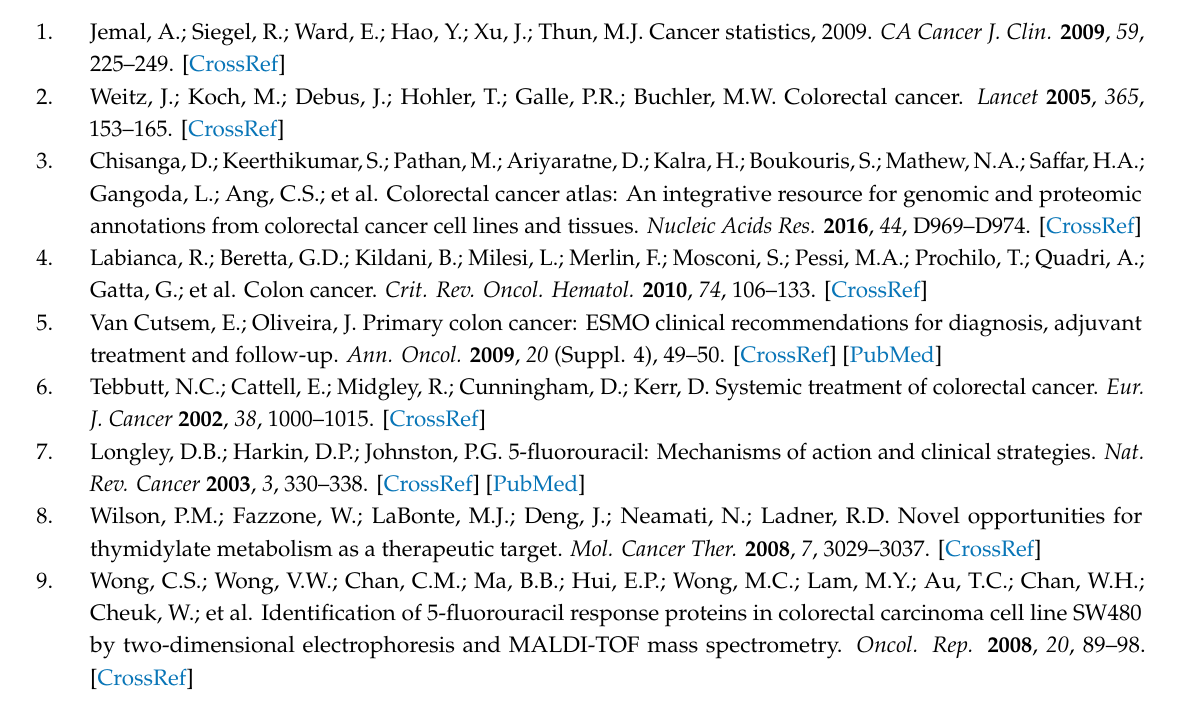
Figure S1: FURD detection using X-caliber Qual browser, Figure S2: FdUMP detection using X-caliber Qual browser, Figure S3: Molecular structures, Figure S4: Chromatograms depicting identification of FdURD, dUMP and TMP from cell lysates and media samples from parental and resistant cells treated with 5-FU, Figure S5: Isotope pattern analysis and fragmentation tree analysis for 5-FU standard using